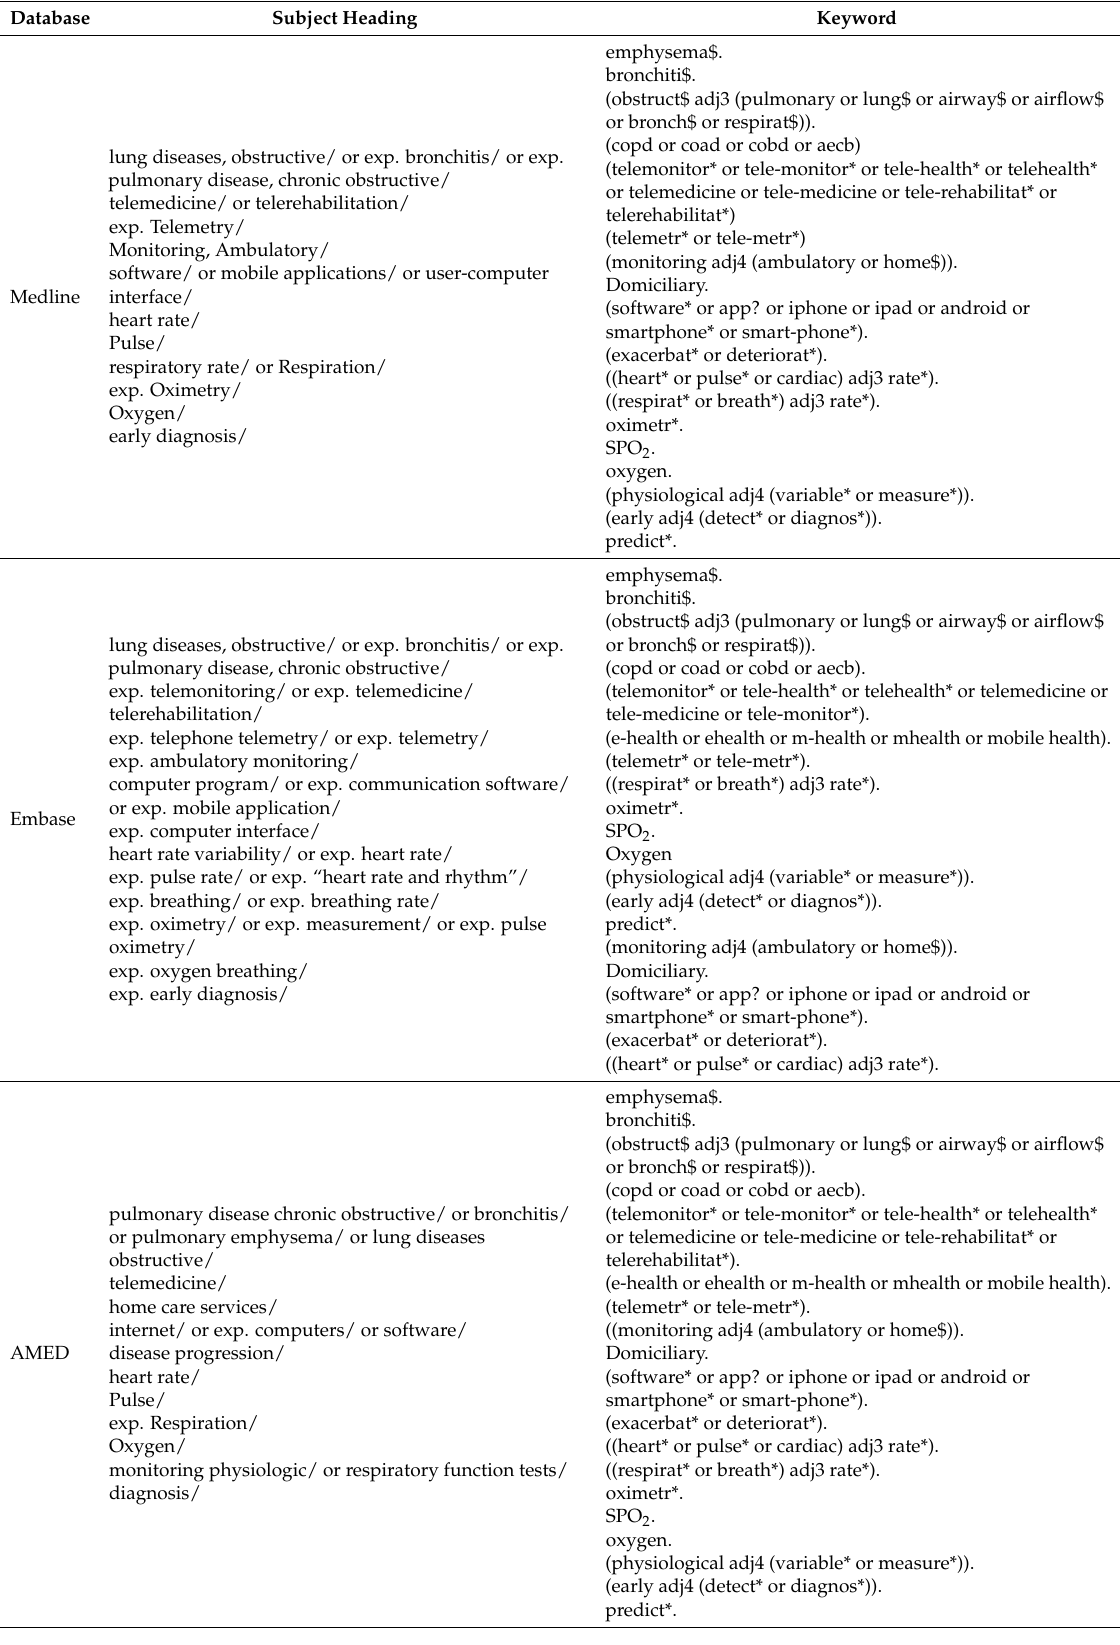
Table A2. Database Search